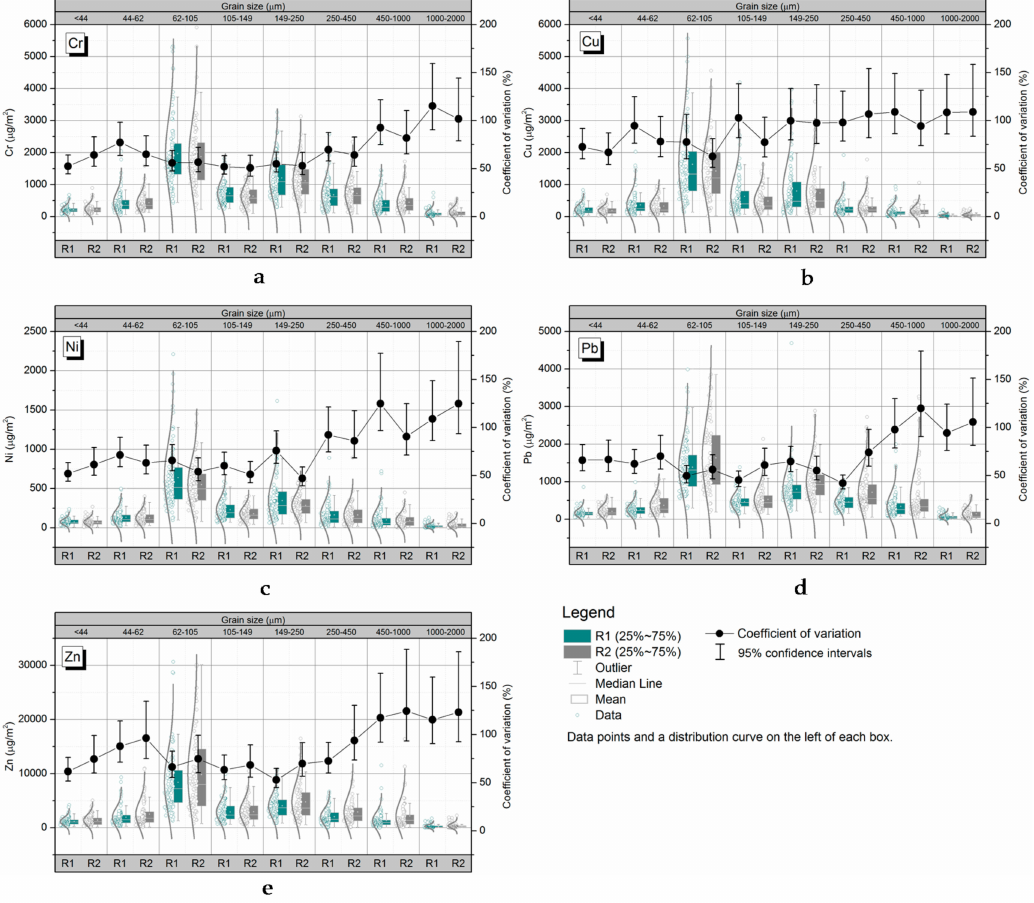
Figure 3. Grain-size heterogeneity in terms of metal load present. Each Cv value shown is the mean ± the 95% confidence interval. ( a ) grain-size variability in Cr loads; ( b ) grain-size variability in Cu loads; ( c ) grain-size variability in Ni loads; ( d ) grain-size variability in Pb loads; ( e ) grain-size variability in Zn